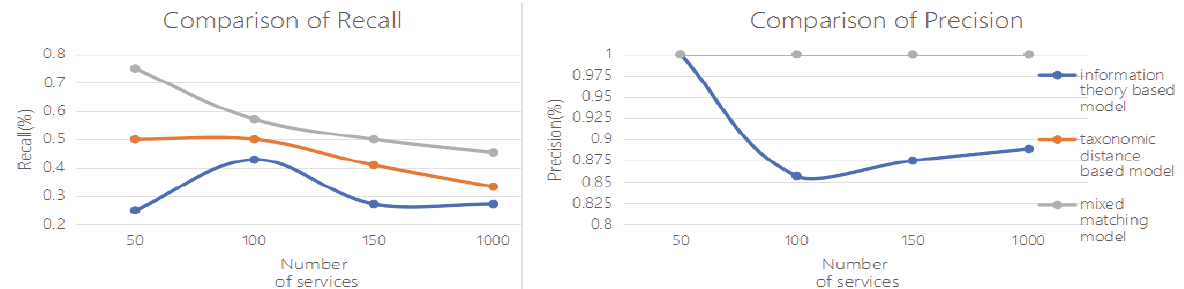
Figure 6: Performance comparison when 𝜃 =